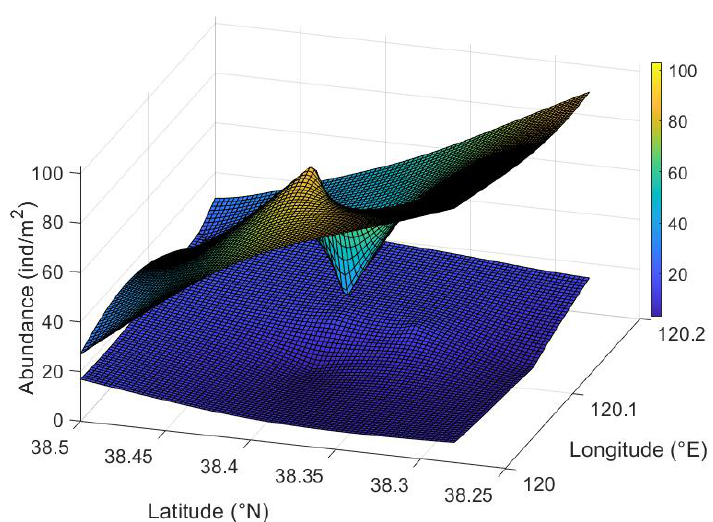
Figure 8. Distribution of the interpolated shellfish concentration. The upper layer is on 15 June, and the lower layer is on 21 June.